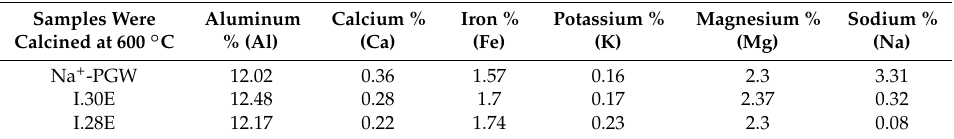
Table 1. Data of ICP-AES chemical analysis of parent sodium montmorillonite PGW, I.28E quartenary octadecyl ammonium organoclay, and I.30E primary octadecyl ammonium organoclay. Samples Were Calcined at 600 ◦ C